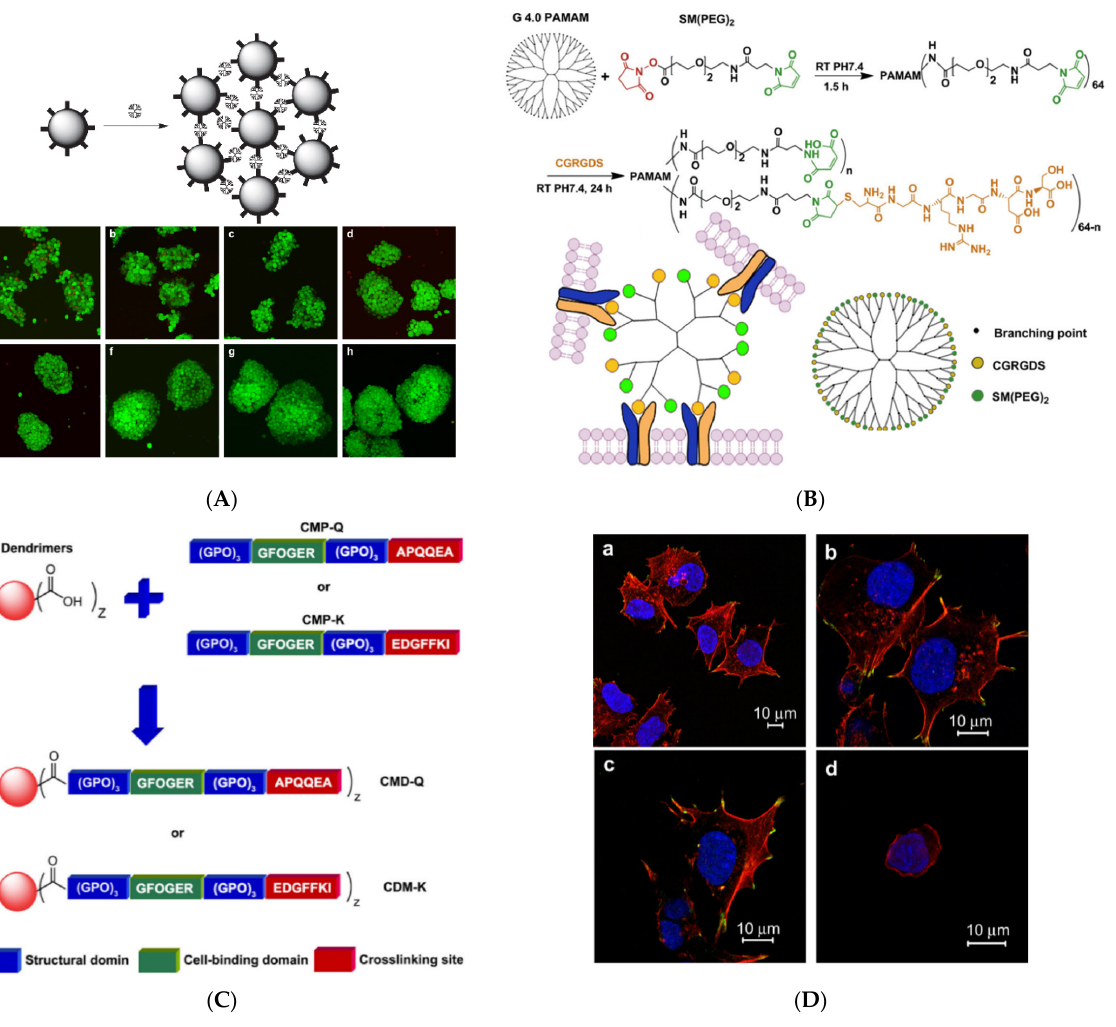
Figure 10. ( A ) Cellular aggregate formation using dendrimer hydrazide as an inter-cellular linker. Surface-modified cells are cross-linked by dendrimer hydrazide to rapidly form the assemblies; introduced aldehyde residues of cell surface modification are schematically indicated by the peripheral short lines; hydrazide dendrimer and confocal images of live (green) and dead (red) HepG2 cells in MCAs on days 0, 1, 2, 3, 4, 5, 6 and 7, respectively, indicated high cell viability, and an increase in MCA size ( a – h ) Reproduced with permission from [145] Copyright: Elsevier Ltd. ( B ) A Synthetic scheme for modification of PAMAM with RGD via a two-step reaction using a heterobifunctional coupling reagent, SM(PEG)2, and a model of RGD-PAMAM interacting with different cells and functioning as “molecular glue” at the multicellular interface. Reproduced with permission from [146]. Copyright: Elsevier Ltd. ( C ) Collagen-mimetic peptides (CMP-Q or CMP-K) supplemented with a cell-binding sequence (GFOGER) and the identified EDGFFKI or APQQEA substrate sequence were conjugated onto a PAMAM dendrimer to create a cross-linkable “biomimetic collagen”. Z denotes the number of peripheral functional groups of the dendrimers available for tethering peptides covalently nearby thus promoting intermolecular interactions and folding. ( D ) Cytoskeletal organization of Hep3B cells as a function of substrates: ( a ) calf-skin collagen, ( b ) crosslinked collagen-mimetic dendrimers (X-CMD), ( c ) PAMAM G1.5–[(GPO)3GFOGER(GPO)3EDGFFKI]7 (CMD-K), and ( d ) GFOGERGGG (CMP00). Cells were fixed and stained for actin stress fibers (TRITC–phalloidin; red), and nuclei (DAPI; blue) after 3 h of adhesion in a serum-free medium and imaged using confocal microscopy (60 magnification). Both were reproduced with permission from [148]. Copyright: Elsevier